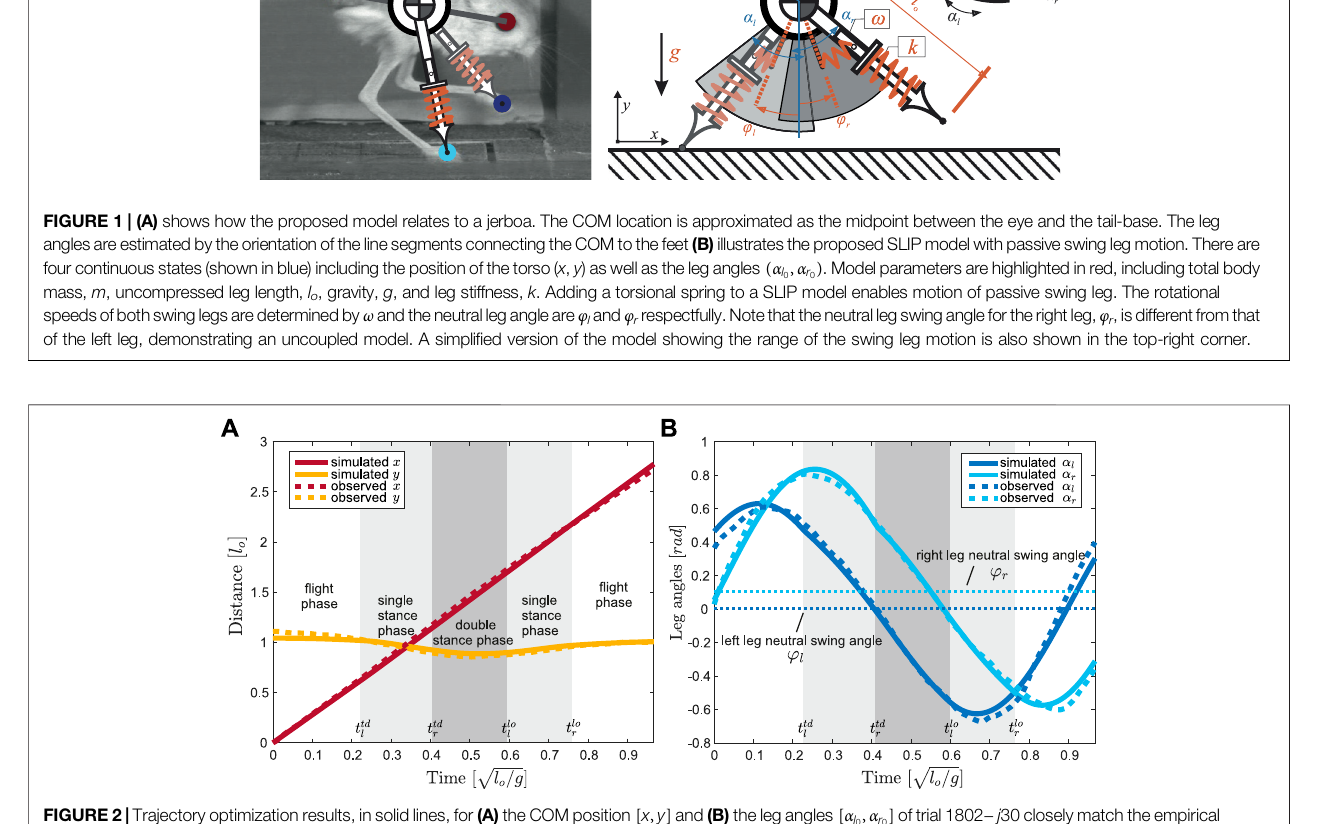
FIGURE2| Trajectoryoptimizationresults,insolidlines,for (A) theCOMposition [ x , y ] and (B) thelegangles [ α l data, in dashed lines. The fi tting result shows whole stride, starting from the apex transition, when t ∈ [ 0 , T ] in the fl ight phase (white background). The single stance phases are indicated by the lighter gray background and the double stance phases are indicated by the darker gray background. Compared to the rotational motion of the left leg (dark blue), the right leg rotations are translated anteriorly (light blue), which is re fl ected in our model by setting the neutral leg swing angles to φ l =0.032 rad and φ r =0.137 rad, marked by horizontal dotted lines in (B) . The difference between φ l and φ r is the offset in uncoupled leg